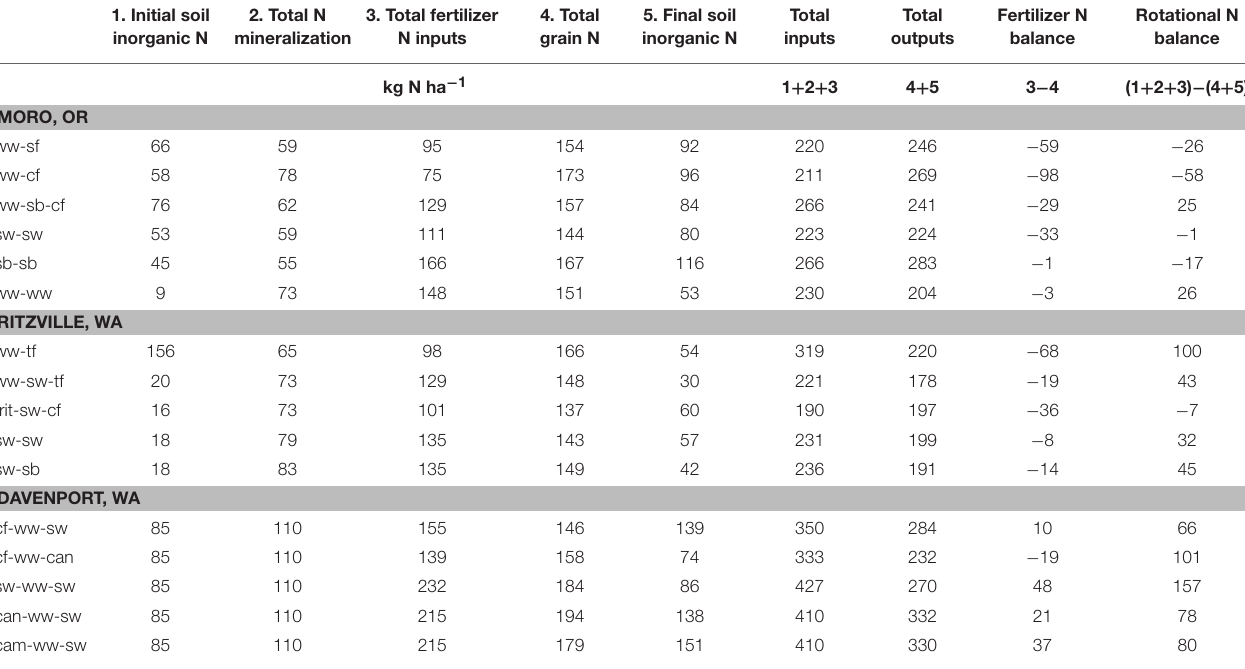
TABLE 5 | Rotational fertilizer and total N balance for Moro, Ritzville, and Davenport from 2012 to 2014. 1. Initial soil 2. Total N 3. Total fertilizer 4. Total 5. Final soil inorganic N mineralization N inputs grain N inorganic